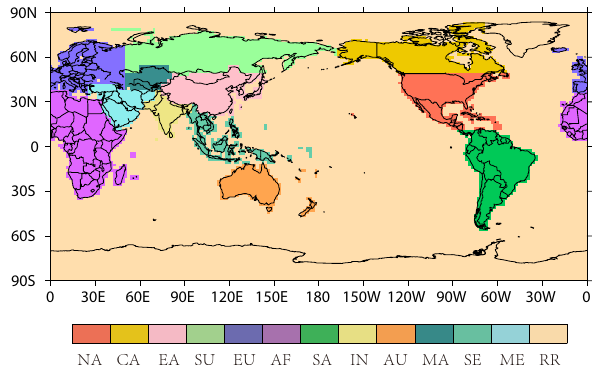
Figure 1. The 13 defined source regions: Canada (CA), North America except Canada (NA), East Asia (EA), the former Soviet Union (SU), Europe (EU), Africa (AF), South America (SA), India (IN), Australia (AU), Middle Asia (MA), Southeast Asia (SE), the Middle East (ME), and the remaining regions